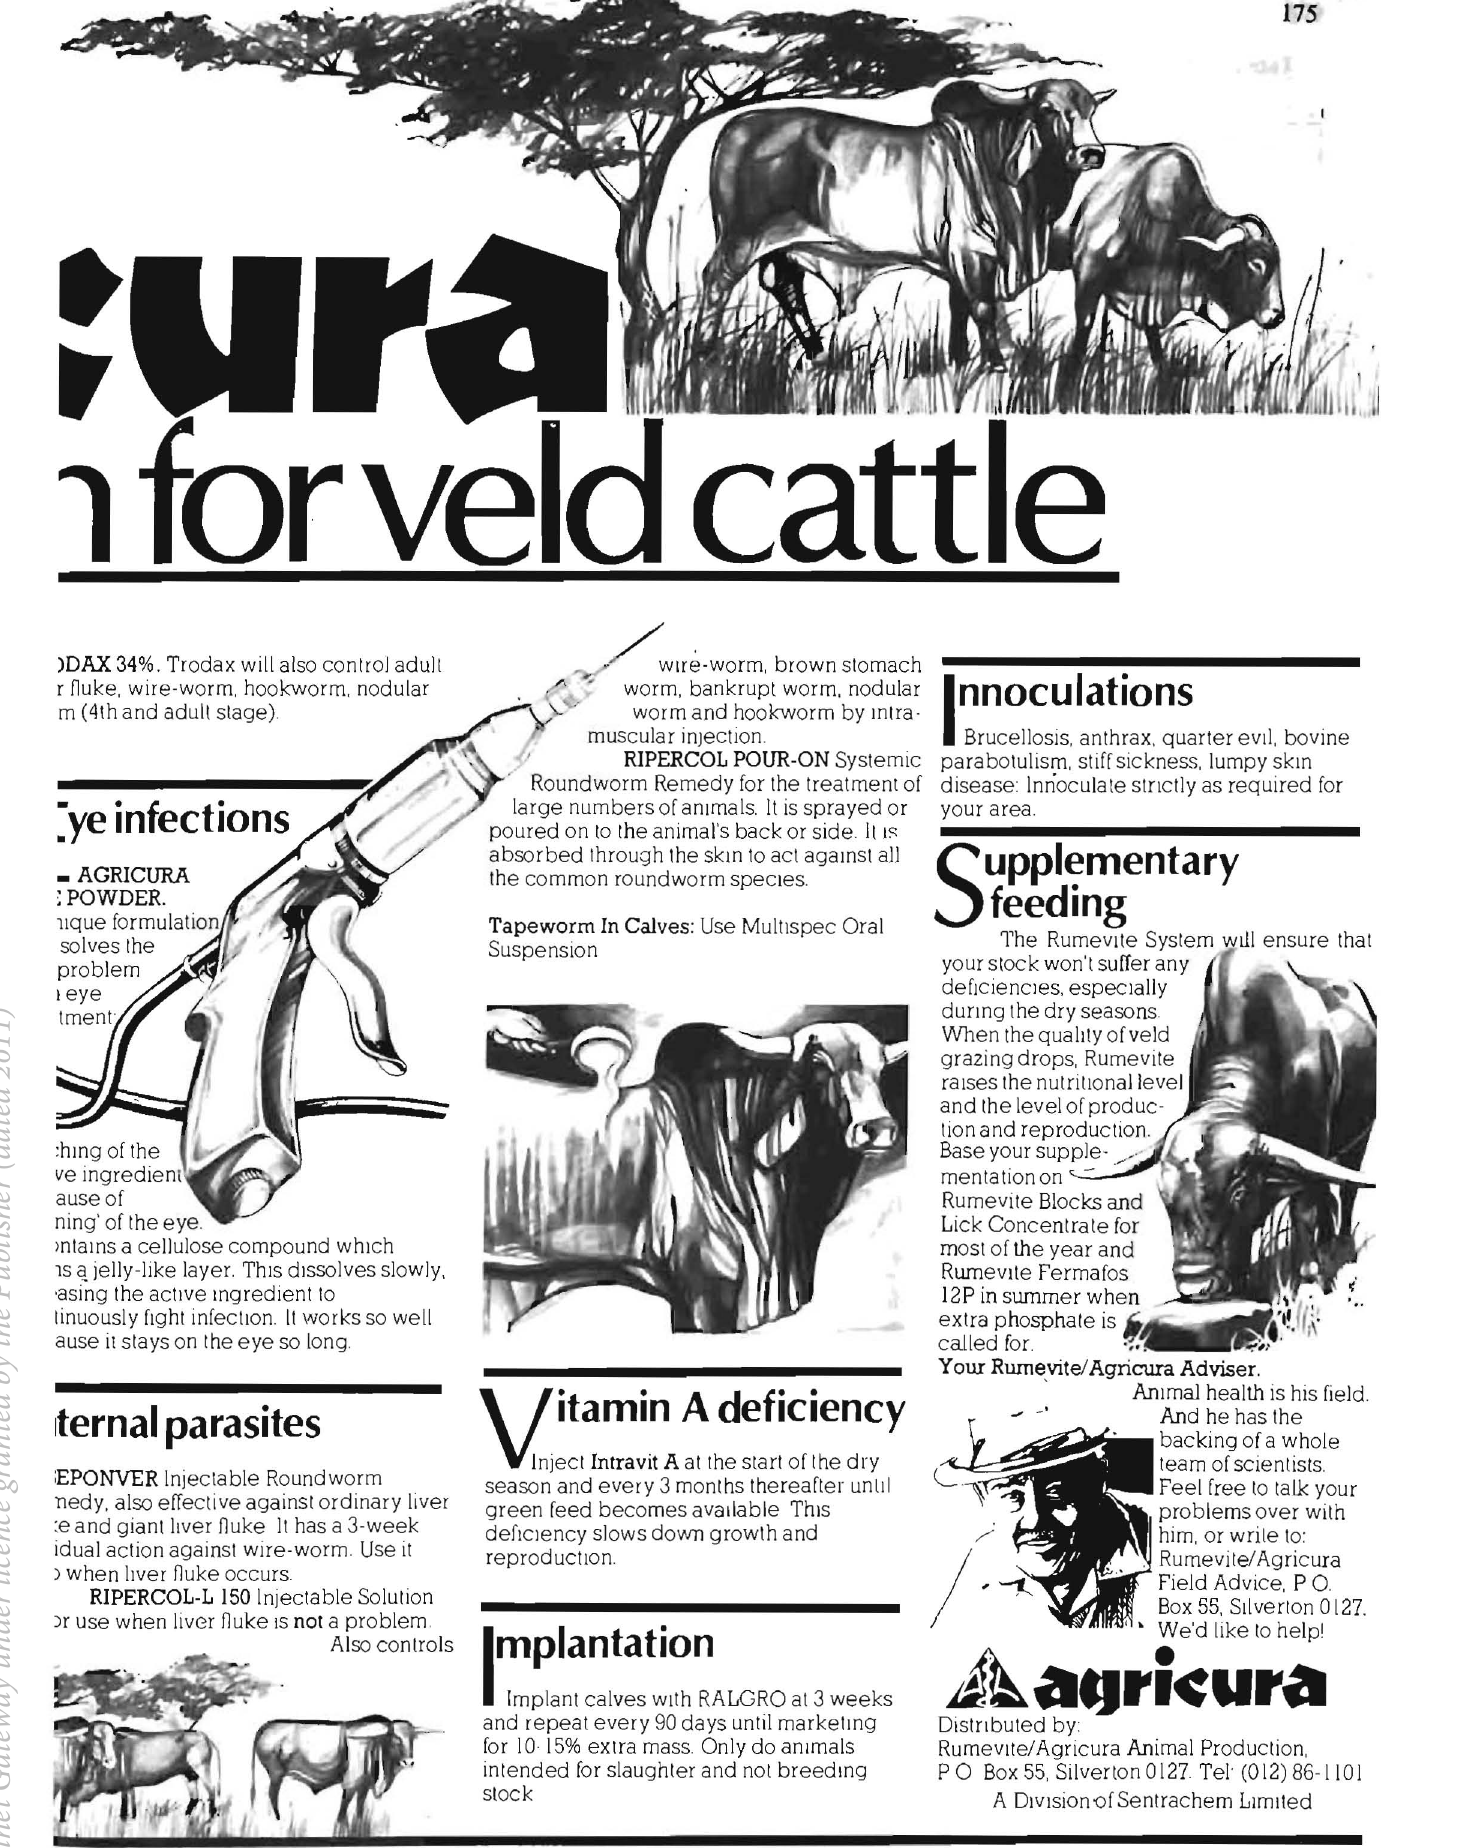
ClaSSification: B2 Agricura Eye Powder (Reg. No. G83 of ACI3& I ~T) AClI'.'C'lngr h:!i11 C!'!lornmpr-nloo' '.0'7', mlm. Sulphacetamide !Y'dl m '0;:,0" mlm. ProOavln L b mlm Seponver Injectable Solution (Reg No. G2s7 of ACI 3€ '194'i) ACllv€ lfI\lred,enr Kloso lei 5 (\ m'v, Classlflcallon B2 Rlpercol L Soluble Powder